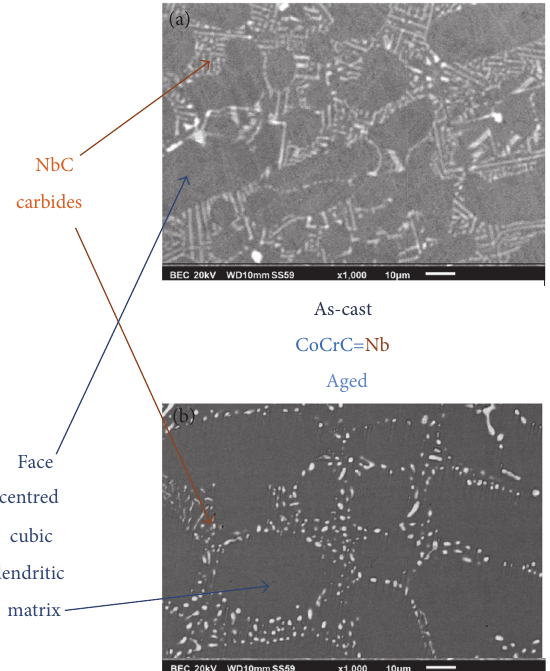
Figure 6: The as-cast (a) and aged (b) microstructure of the “CoCrC=Nb” alloy (SEM/BSE